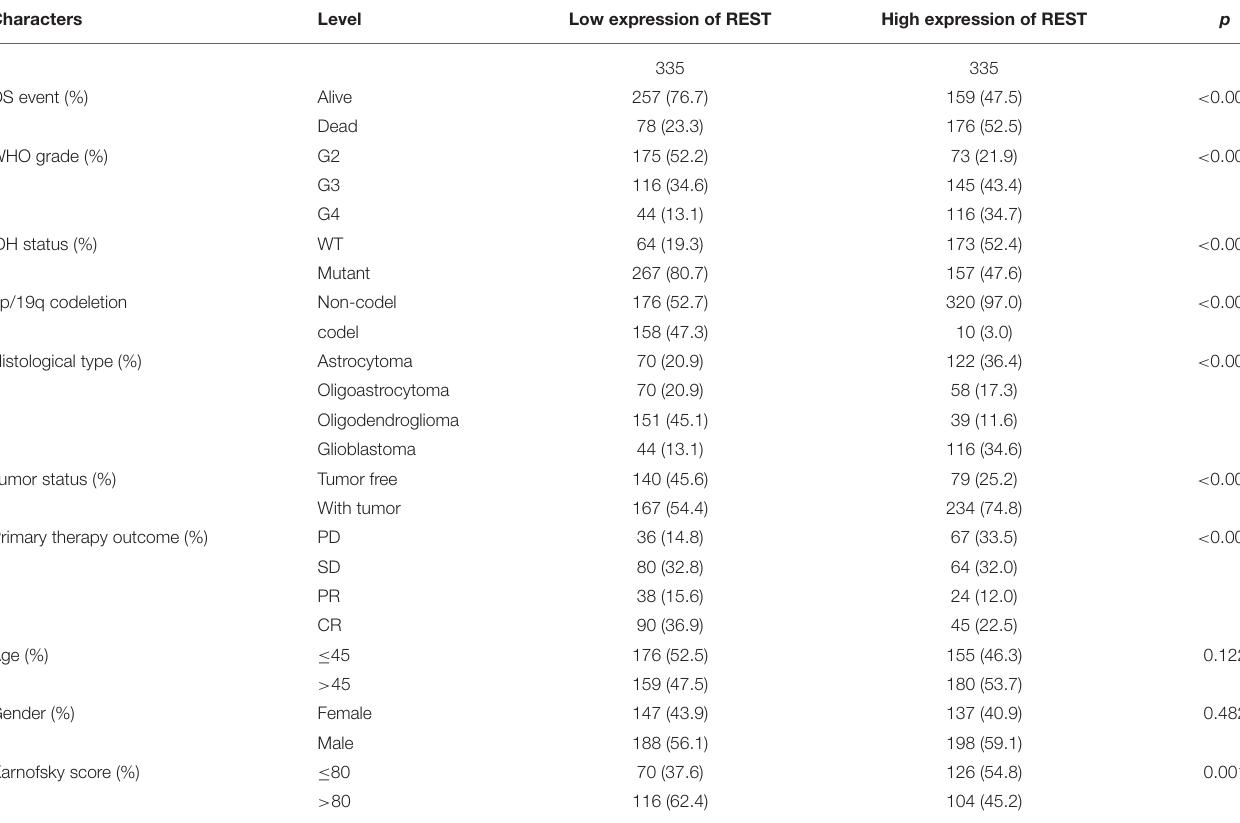
TABLE 1 | Correlation between REST expression and clinical characteristics in glioma patients.